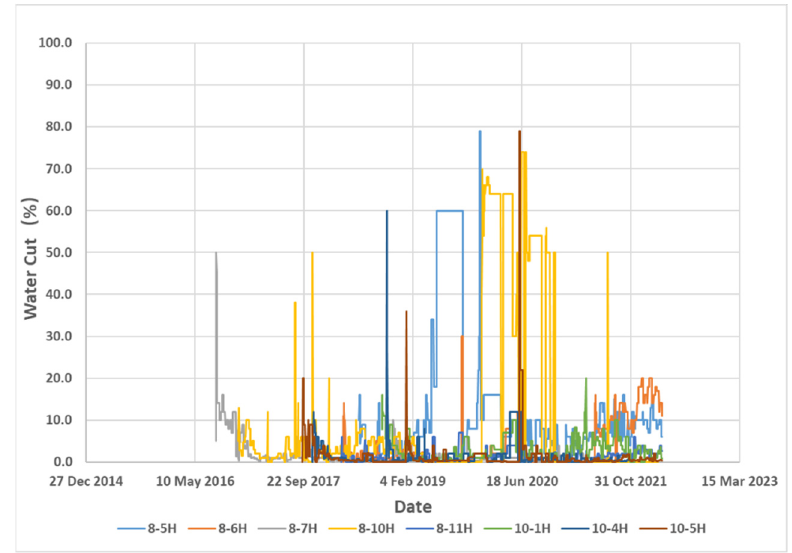
Figure 25. Water cut variation curve of injection ‐ production horizontal well pattern.